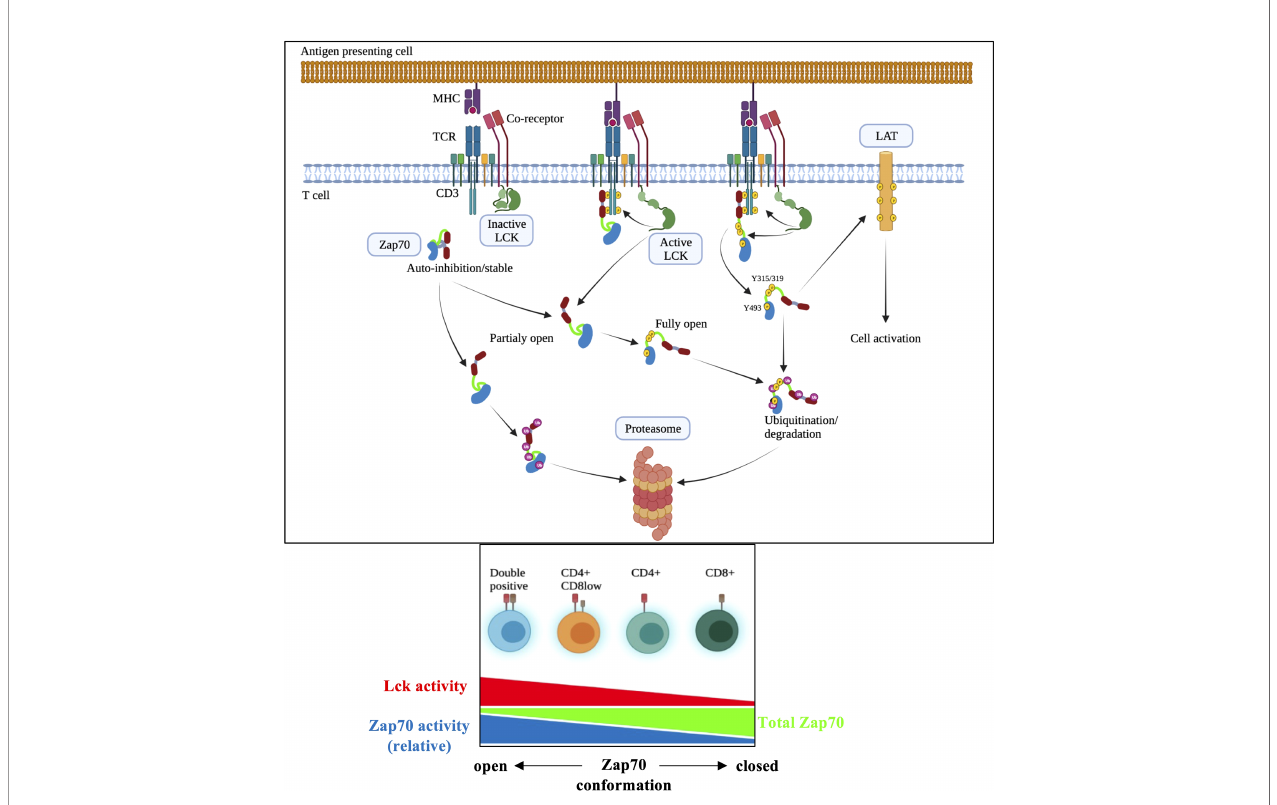
FIGURE 8 | Model of Lck-mediated regulation of Zap70 expression/activation in T cell activation. In DP thymocytes higher amount of Zap70 is associated with surface TCR complex compared with mature T cells (ref 39) likely due to higher Lck activity resulting from CD4 and MHCII interaction (ref 15). We propose that the closed auto-inhibited conformation of Zap70 is stable and upon its recruitment to phosphor-CD3 chains Lck-mediated phosphorylation of Y315/Y319 and Y493 results in partially or fully active Zap70 essential for signal transduction during thymic maturation and mature T cell activation. However, partially or fully active Zap70 must be rapidly degraded to prevent potentially dominant negative effect of partially active Zap70 or over-activation during thymic development or mature T cell response to ligand. Partially or fully open but free (not associated with phospho-CD3) Zap70 may be rapidly degraded as well thereby preventing undesired antigen independent signaling during thymic development. It is quite possible that association of partially open Zap70 with phospho-CD3 may protect it from